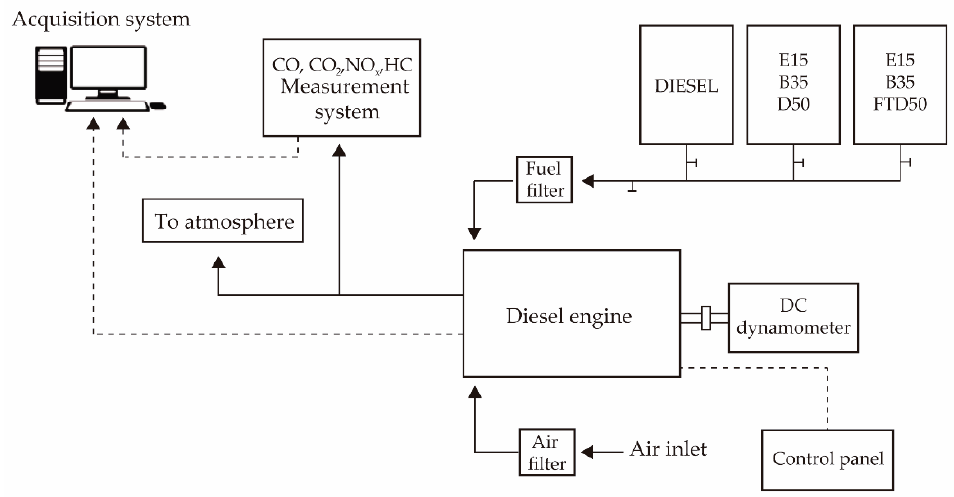
Figure 1. Schematic diagram of the experimental setup.